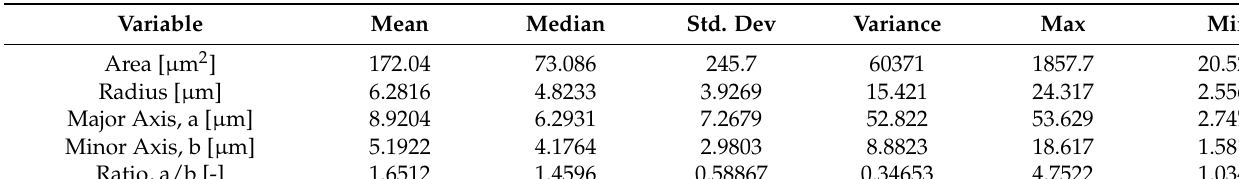
Table 18. Void data for Plate 3.